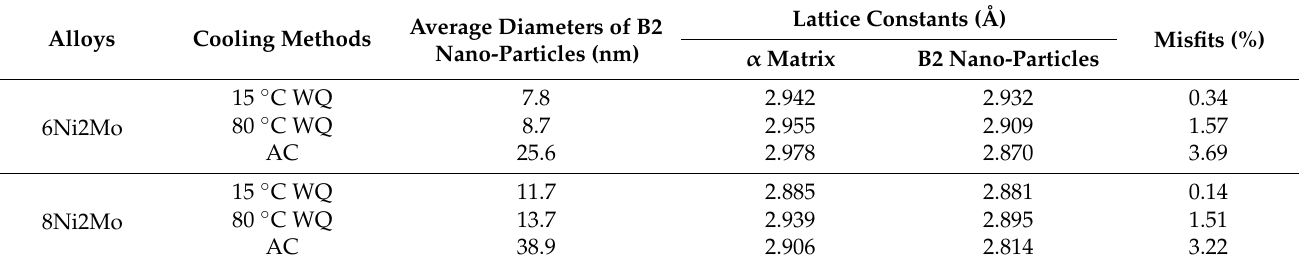
Figure 7. Vickers hardness of the 15 °C water-quenched 6Ni2Mo ( a ) and 8Ni2Mo ( b ) alloys subjected to aging at 200 °C for different times, followed by 338 days natural aging.